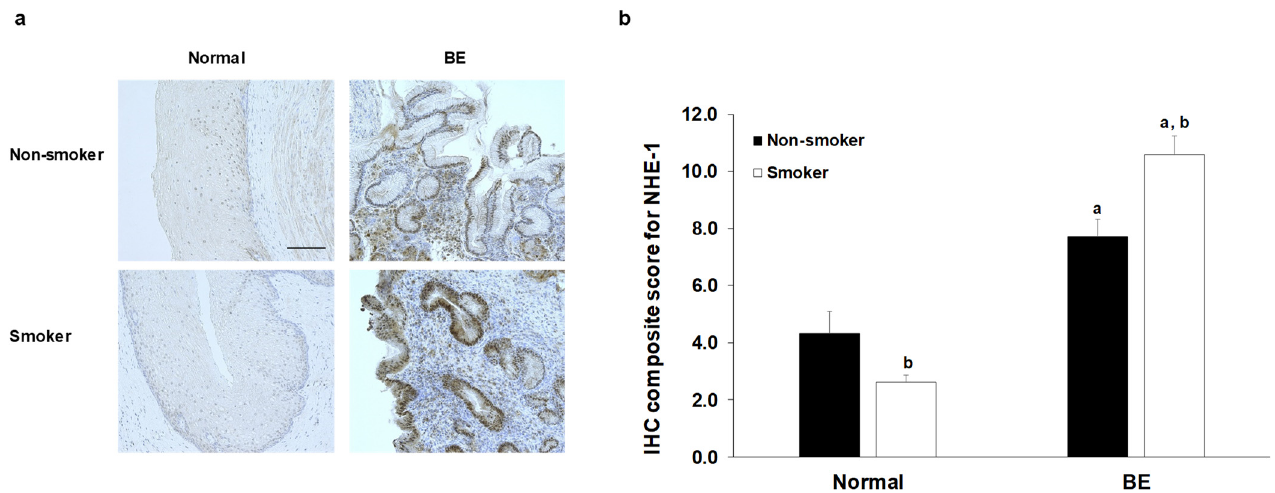
Figure 6. Expression of Na + /H + exchanger-1 (NHE-1) in human esophageal samples. ( a ) Representative immunohistoche- mical stainings show the presence of NHE-1 in human esophageal samples. Scale bar represents 100 µm. ( b ) Quantification of DAB intensities were calculated, using a semi-quantitative scoring system. Data represent mean ± SEM of 23–25 specimens/3–6 patients each group; a = p ≤ 0.05 vs. normal; b = p ≤ 0.05 vs. non-smoker. BE: Barrett’s esophagus.